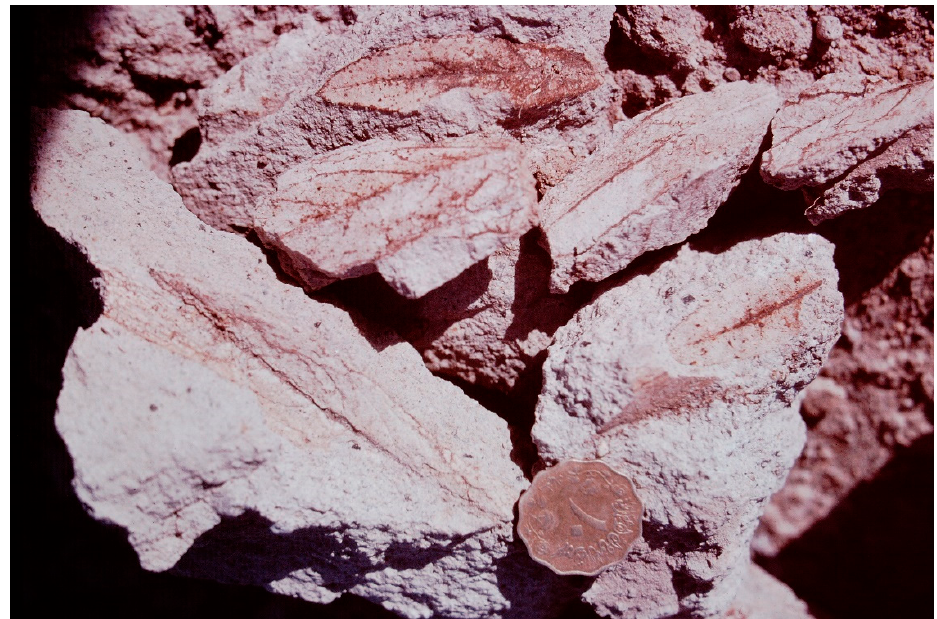
Figure A8. Oil palm leaf fossil preserved in volcanic ash south of the Jebel Marra volcano in arid western Sudan. The ash was erupted a million years ago during a wetter climatic phase.